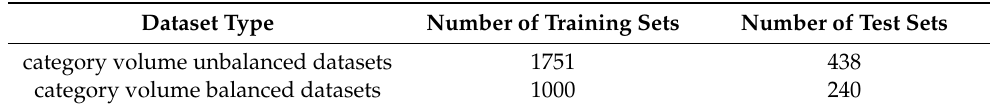
Table 2. Sorted datasets. Dataset Type Number of Training Sets Number of Test Sets category volume unbalanced datasets